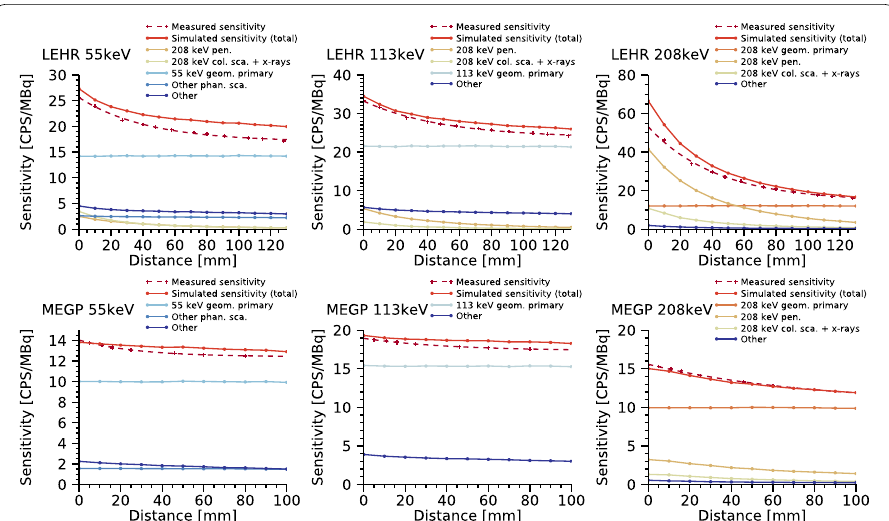
Fig. 7 Simulated and measured system sensitivities as function of the source-collimator distance for 177 Lu for the LEHR and MEGP collimators and energy windows positioned over 55 keV, 113 keV and 208 keV. Simulated data are connected with straight lines, for measured data a function is fitted. Simulated sensitivities are separated into sub-components based on the emission energy and events in the photon transport, including collimated primary (geom. primary), phantom scatter (phan. sca.), collimator penetration (pen.), collimator scatter (col. sca.) and collimator x-rays (x-rays). Components with a low contribution are grouped together